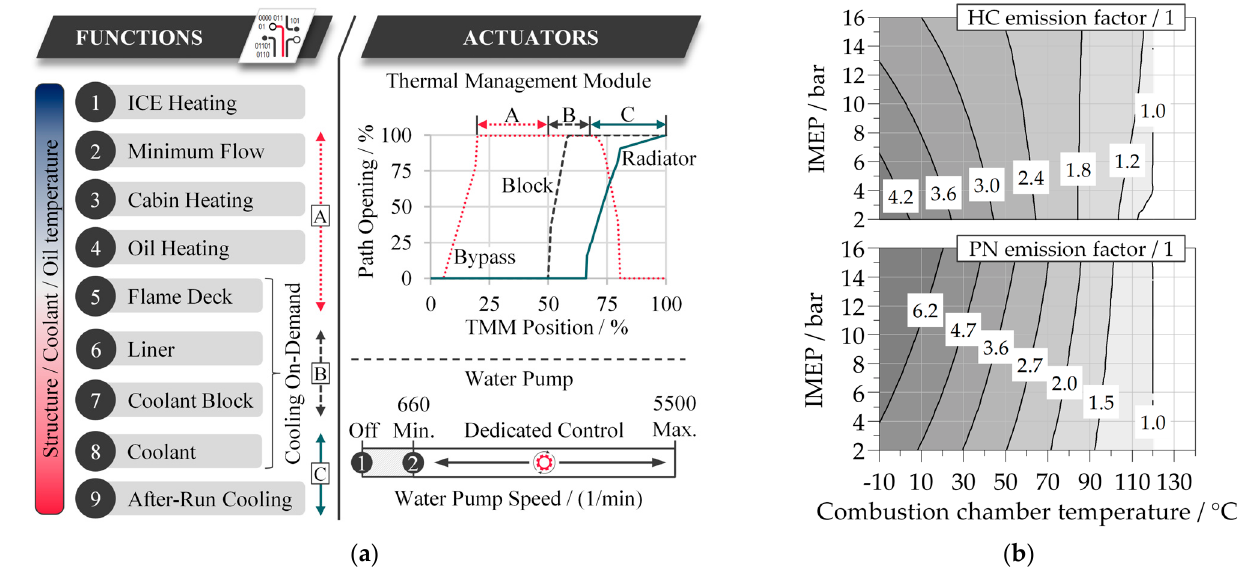
Figure 8. ( a ) Function definition (left side), pump and TMM control (right side); ( b ) Relative HC and particulate raw emissions referred to T Coolant = 90 °C for a variation of average combustion chamber temperature T CCW and engine load p mi .